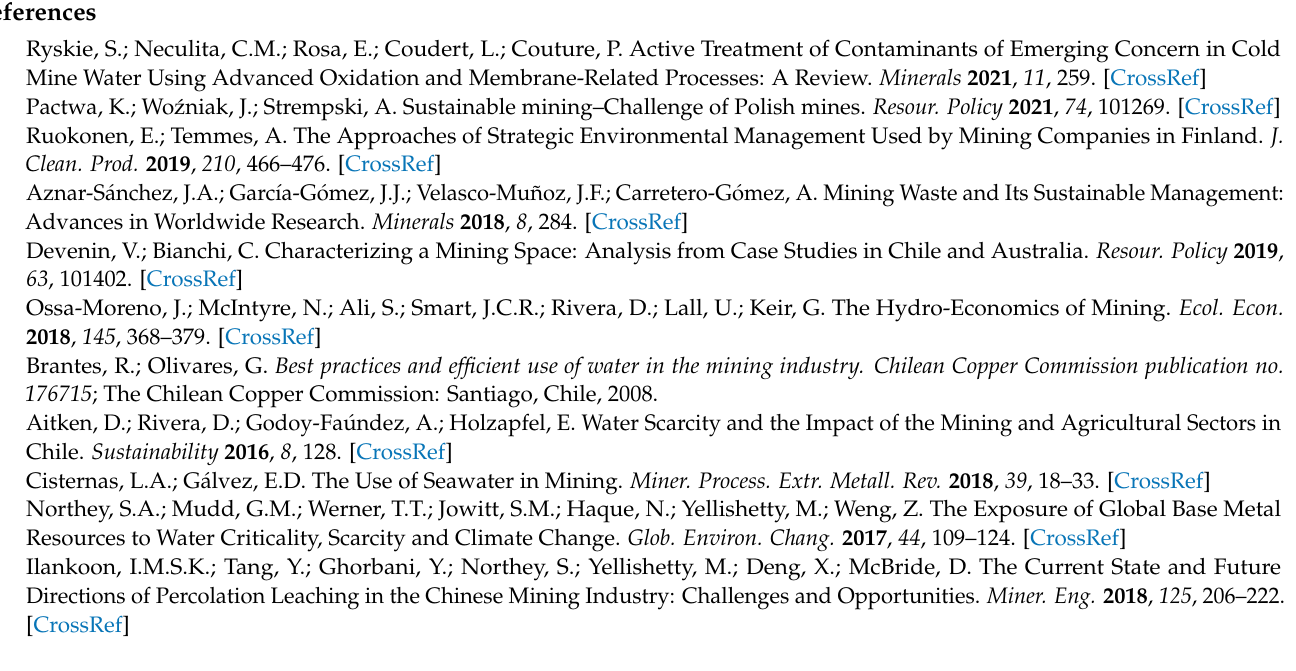
Figure A1. A flow chart adapted from the PRISMA 2020 statement which presents the literature Figure A1 . A flow chart adapted from the PRISMA 2020 statement which presents the included literature included [128].